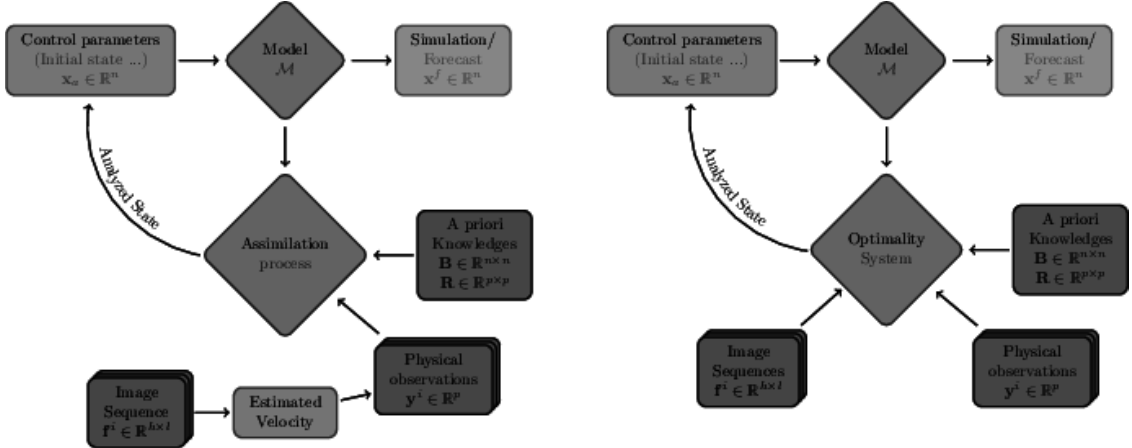
Figure 5. Schematic representation of the use of images in data assimilation: assimilation of pseudo-observations (left panel); direct assimi- lation of images (right